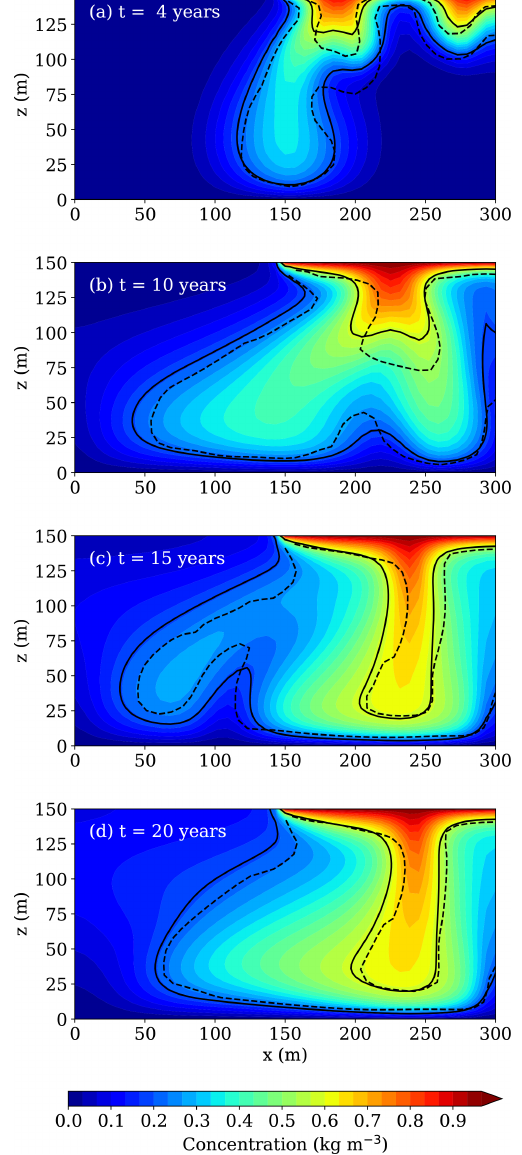
Figure 6. Comparison of the simulation results for the Elder prob- lem using the upwind advection scheme (solid lines and contours) against SHEMAT’s Smolarkiewicz advection scheme implementa- tion results (dashed lines) for the 0.2 and 0.6 isochlors at simulation times of (a) 4 years, (b) 10 years, (c) 15 years and (d) 20